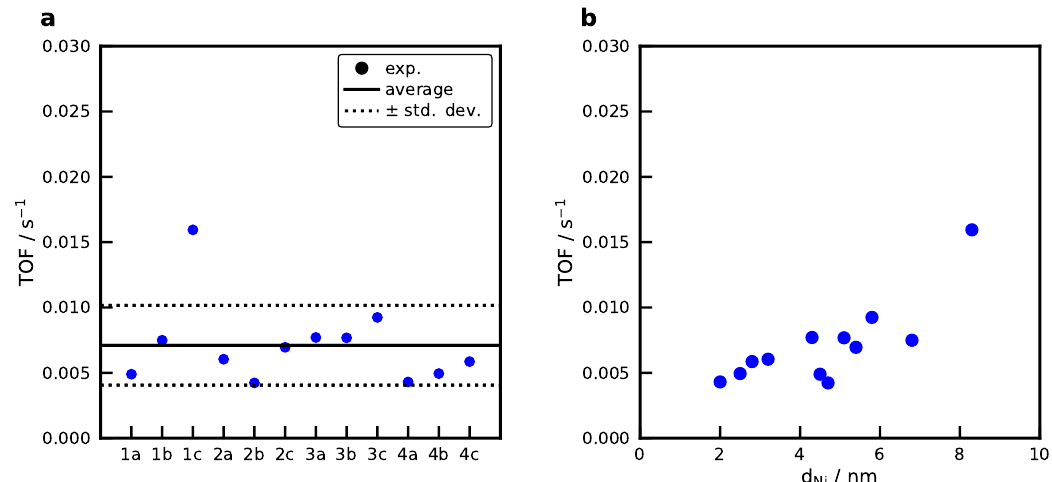
Figure 12. ( a ) Turnover frequencies (CO 2 to CH 4 ) of the Ni/SiO 2 catalysts at a temperature of 530K. For the naming convention of the samples refer to the production tree Figure 1. ( b ) Turnover frequency in dependence of the Ni particle size. Conditions: m cat = 30mg, β = 20Kmin − 1 , < WHSV = 100L N h − 1 g − 1 , X CO 2